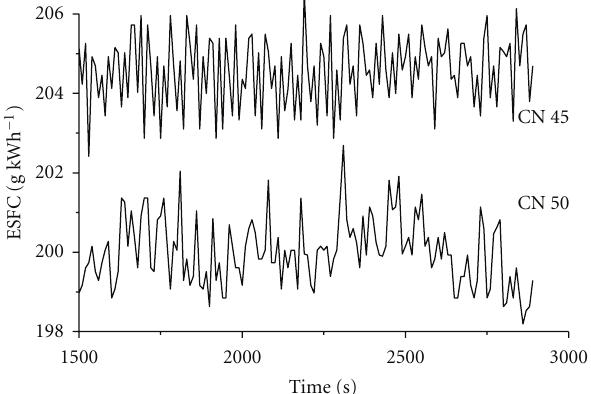
Figure 6: ESFC (g kWh − 1 ) of the S1400 51 and S1100 45 fuels as a function of